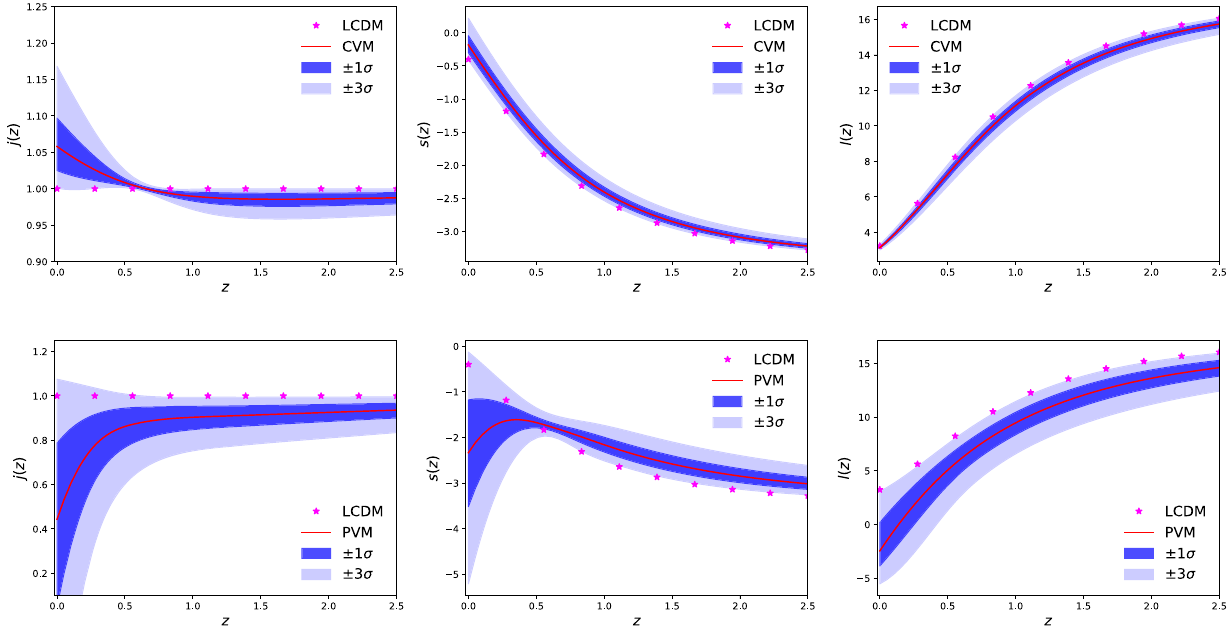
Fig. 3 Cosmographicparameterreconstruction.Fromlefttoright,itisthejerk(j),snap(s),andlerk(l)parameters.Attoppanelisthecosmographic variables for the constant model and at the bottom is the ones for the polynomial model